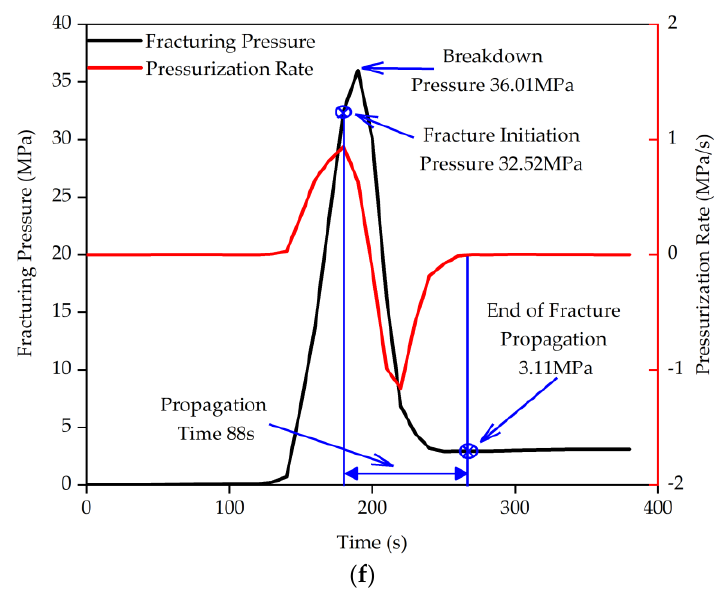
Figure 8. The fracturing pressure – time curves and pressuring rate – time curves: ( a ) – ( f ) are the hydraulic pressure curves and pressure rate curves when the injection flow rate is 5, 10, 15, 20, 25, and 30 mL/min, respectively.